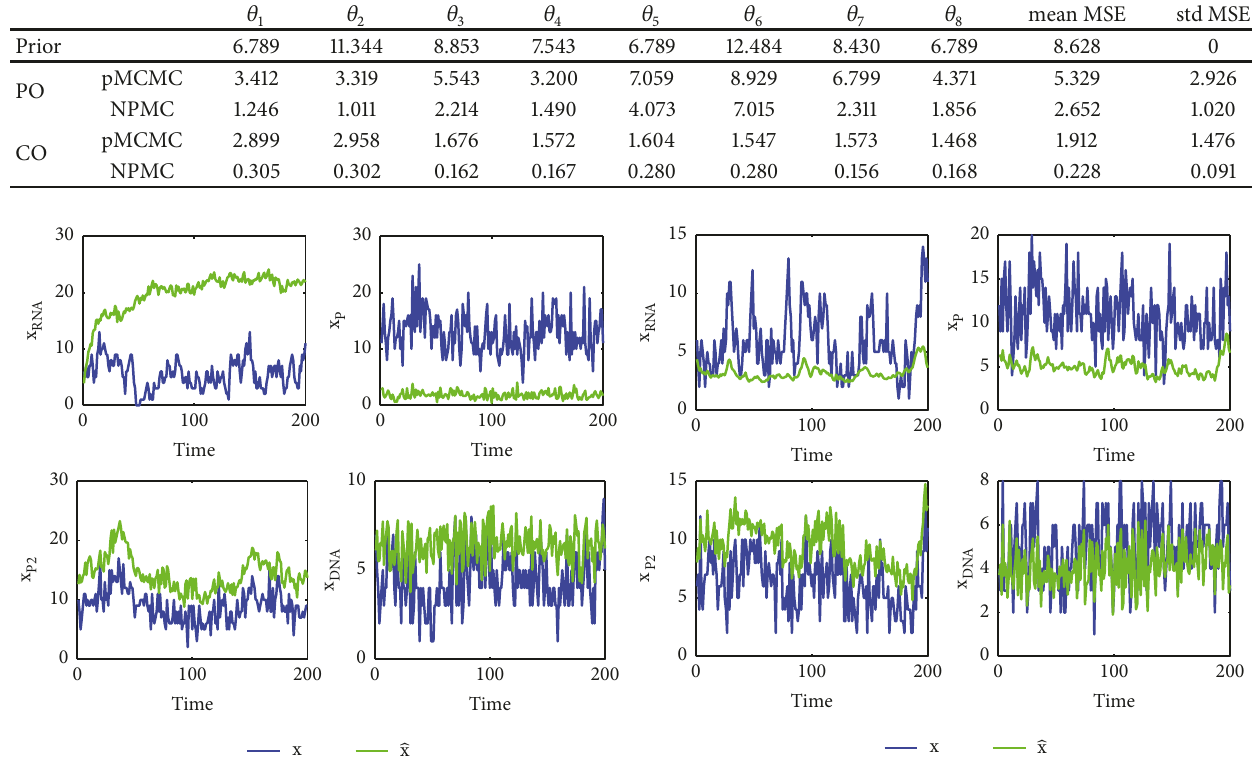
Figure 9: Posterior mean ̂ x = 𝐸 𝑝( x | y ) [ x ] of the populations of all species obtained in the average simulation run of the pMCMC ( left ) and the NPMC ( right ) schemes, in the PO